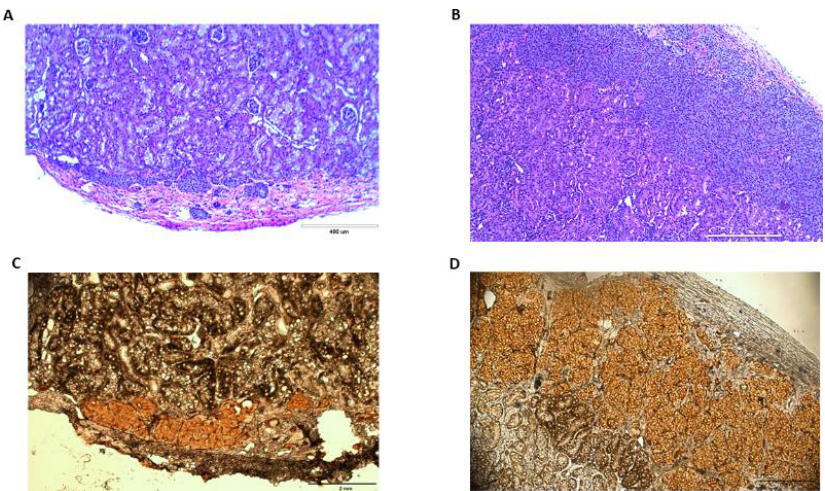
Figure 8. Histology and immunohistochemistry of graft-bearing kidneys at 22 weeks after transplantation with PPIs cultured for 7 days in control media or media supplemented with Nec-1 on day 3 of tissue culture. Graft-bearing kidneys were recovered at 22 weeks after islet transplantation for histological and immunohistochemical analysis. ( A ) Representative photomicrograph of graft-bearing kidneys stained with hematoxylin and eosin from hyperglycemic mice transplanted with PPIs cultured for 7 days in control media. ( B ) Representative photomicrograph of graft-bearing kidneys stained with hematoxylin and eosin from normoglycemic mice transplanted with PPIs cultured for 7 days in media supplemented with Nec-1 on day 3 of tissue culture. ( C ) Representative photomicrograph of graft-bearing kidneys stained with insulin from hyperglycemic mice transplanted with PPIs cultured for 7 days in control media. ( D ) Representative photomicrograph of graft-bearing kidneys stained with insulin from normoglycemic mice transplanted with PPIs cultured for 7 days in media supplemented with Nec-1 on day 3 of tissue culture. Scale bar = 400 µ m (Figure 8A,B) and 2 mm (Figure